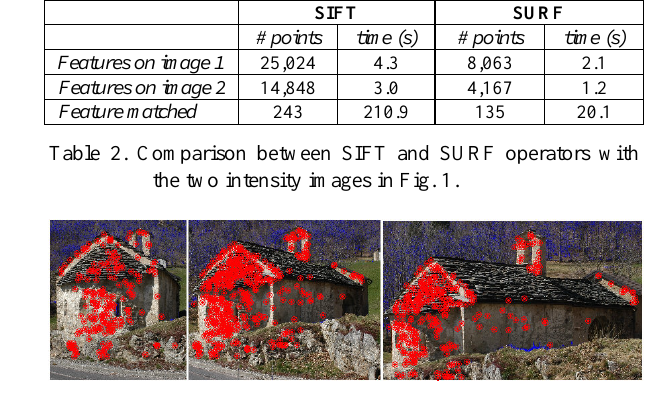
Figure 2. Key-points for a ‘pano-RGB’ triplet matched with SIFT in less than 1